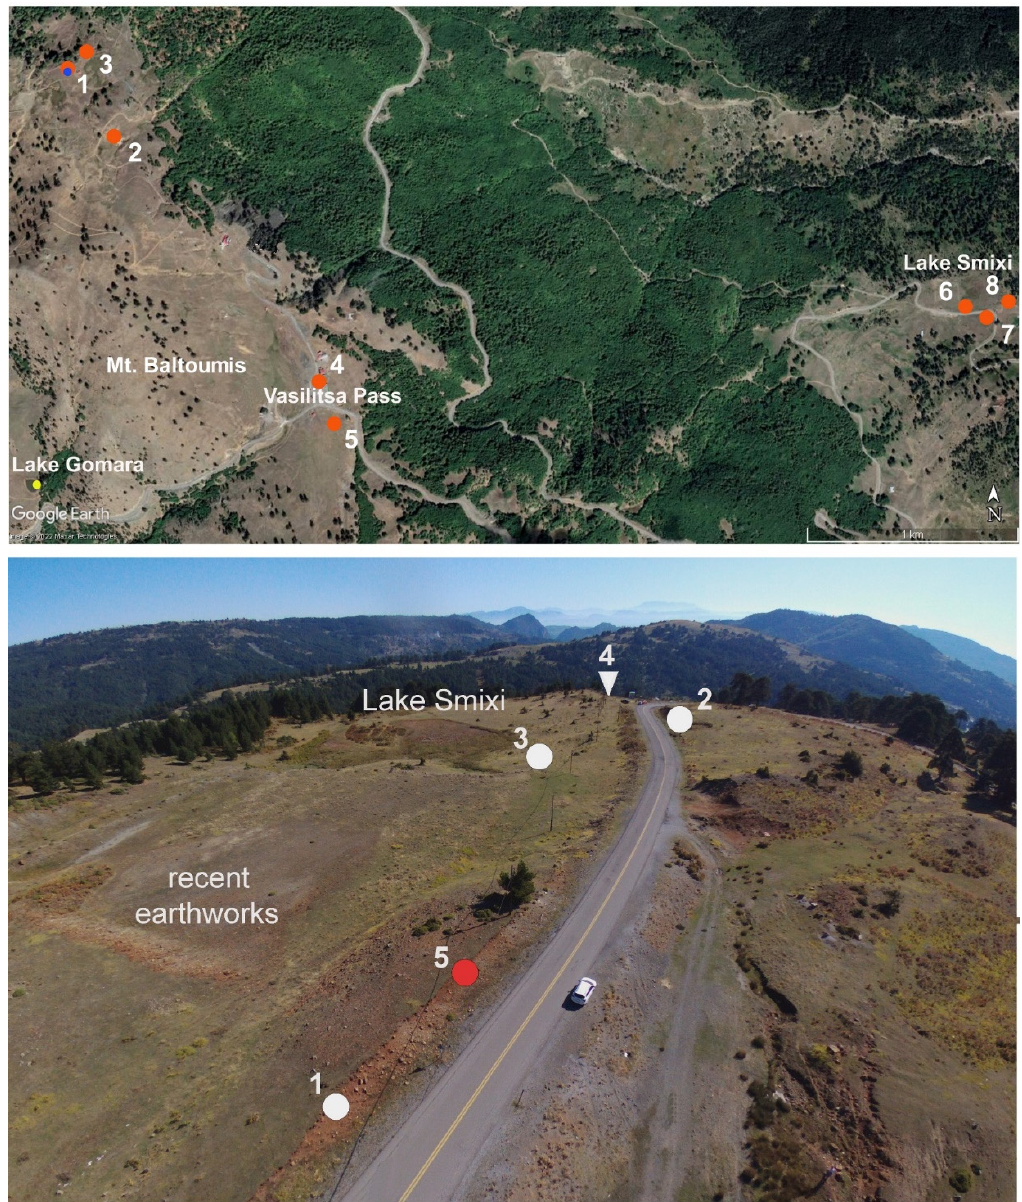
Figure 10. Distribution map of the prehistoric sites discovered in the Vasilitsa Pass (VSL 4 and VSL 5: nn. 4 and 5), along the northern slope of Mount Baltoumis (VSL 1, VSL 2 and VSLA: nn. 1–3), and Lake Smixi (nn. 6–8) ( top ). Lake Smixi location of the finds: refitting Levallois flakes (n. 1), Mousterian discoid cores and pre-core (n. 2), Upper Palaeolithic retouched point (n. 4), early Bronze Age small pit radiocarbon-dated to 3645 ± 35 BP (GrA-69503: SMX-1) from one pine charcoal fragment (n. 5) ( bottom ). The white dots and the triangle refer to the Palaeolithic artefacts, the red dot to the Bronze Age pit (drawing by P. Biagi).